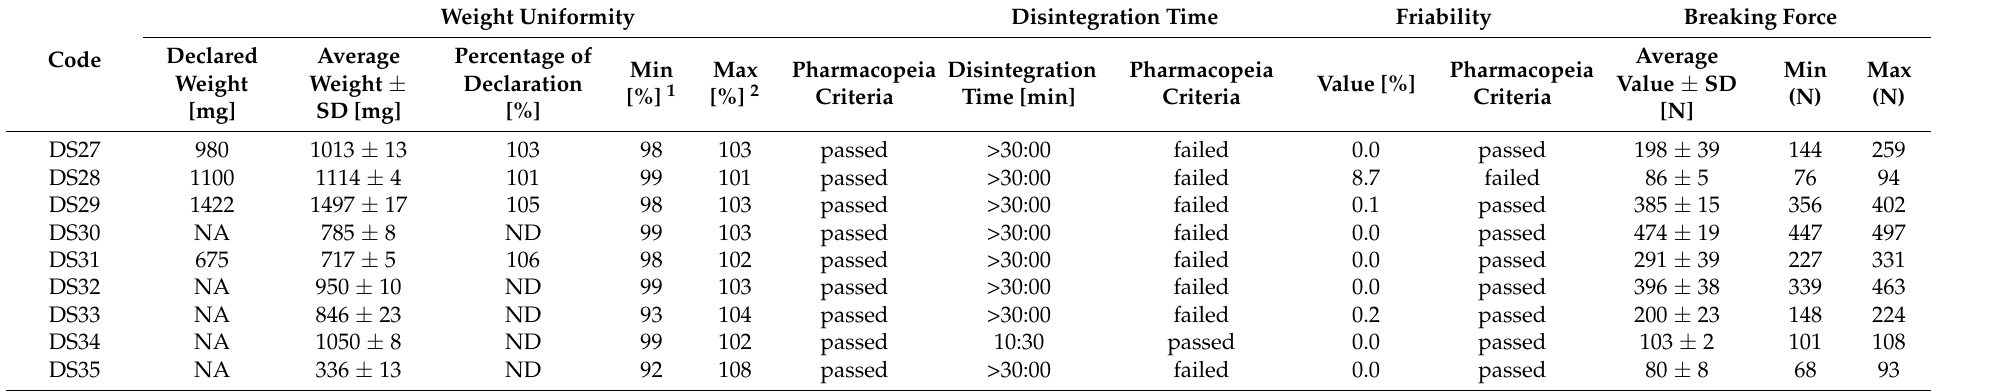
Table 3. Physical parameters of the dietary supplements in tablet form.